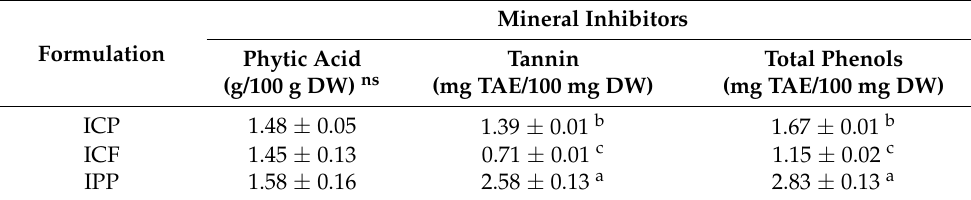
Table 5. Mineral inhibitor content of instant porridge powders.